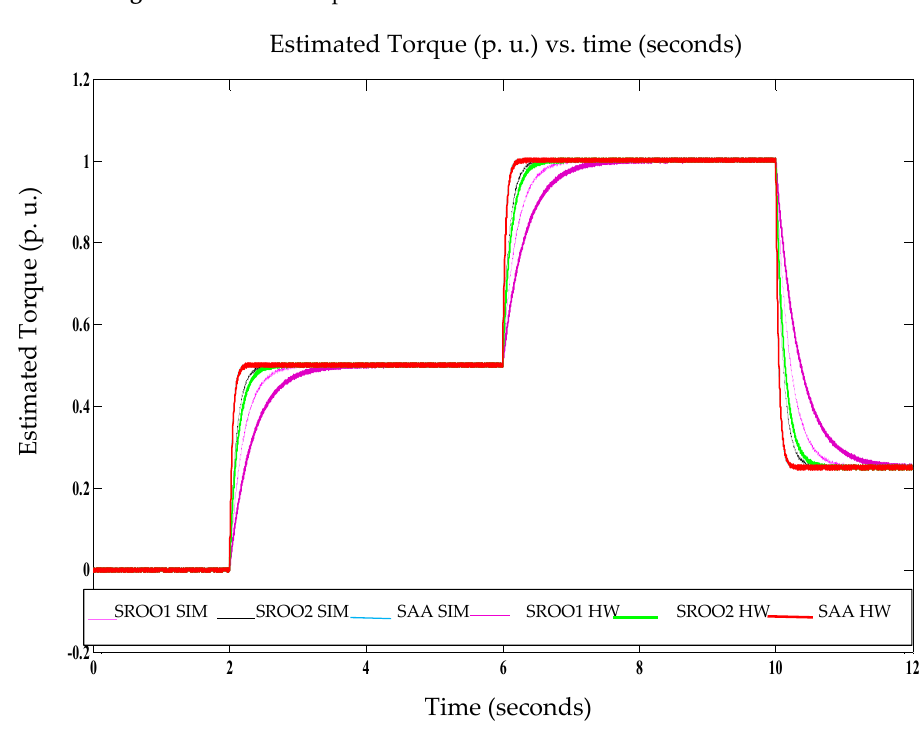
Figure 11. Estimated torque.